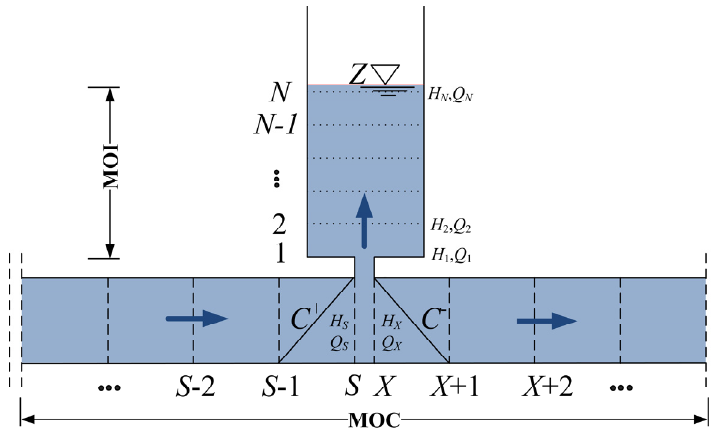
Figure 13. Computational grid for the surge